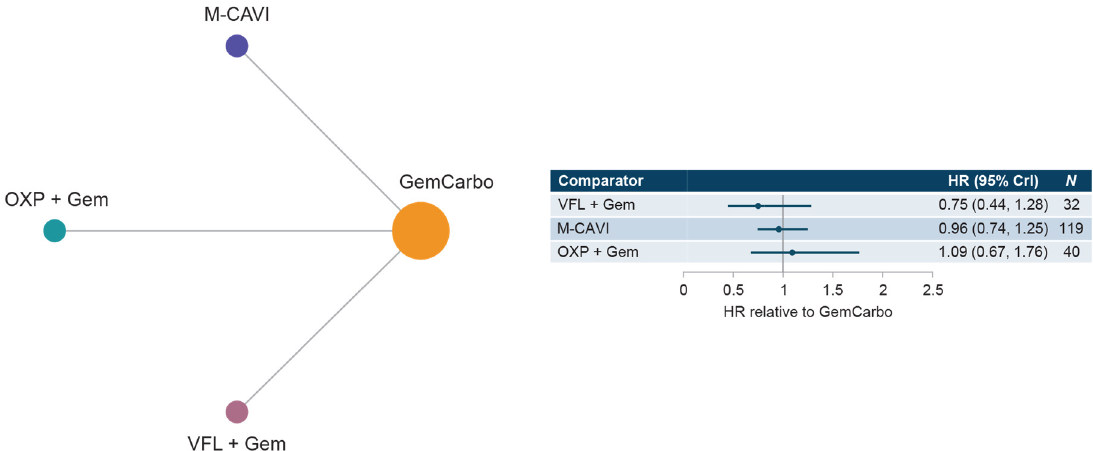
Figure 6. Network diagram and HR for PFS by treatment network for the cis-ineligible (strict) network. Abbreviations: CrI, credible interval; Gem, gemcitabine; GemCarbo, gemcitabine + carboplatin; HR, hazard ratio; M-CAVI, methotrexate + carboplatin + vinblastine; OXP, oxaliplatin; PFS, progression-free survival; VFL, vinflunine.